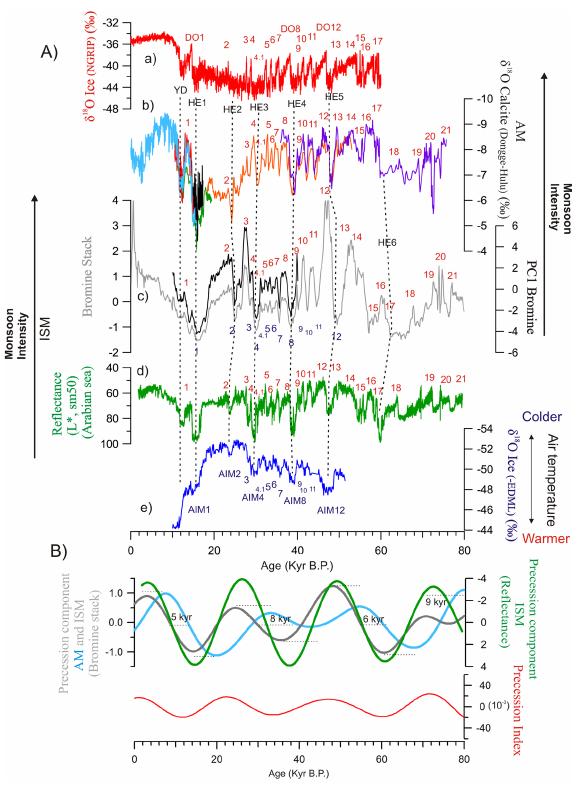
Fig. 7. Comparison between Indian summer monsoon (ISM) changes, the Asian monsoon (AM) and bipolar climate variability over the last 80kyr. (A-a) NGRIP δ 18 O ice record from Greenland (NGRIP members, 2004). (A-b) Chinese speleothem δ 18 O calcite record (Wang et al., 2001, 2004; Yuan et al., 2004; Dykoski et al., 2005) as a proxy for AM. (A-c) Bromine stack and PC1-bromine as a proxy for ISM. (A-d) Reflectance record as a proxy for ISM (De- plazes et al., 2013). (A-e) EPICA Dronning Maud Land (EDML) δ 18 O ice record from Antarctica (EPICA community members, 2006) (note that the scale is inverted). Dansgaard–Oeschger (DO) events and Antarctic isotope maxima (AIMs) are labelled accord- ing to NGRIP members (2004) and EPICA community members (2006). The Younger Dryas and Heinrich events (HEs 1–6) are also indicated. (B) Precession component of the ISM and AM after tun- ing the millennial bromine stack events to the Chinese speleothem δ 18 O calcite events. The precession component of the reflectance record (Deplazes et al., 2013) on its original age scale is also visible for comparison. Dashed lines indicate a time gap between Indian and Asian records in the precession band. A relatively constant gap of 7kyr on average is evident. The precession index is also indicated (Laskar et al.,